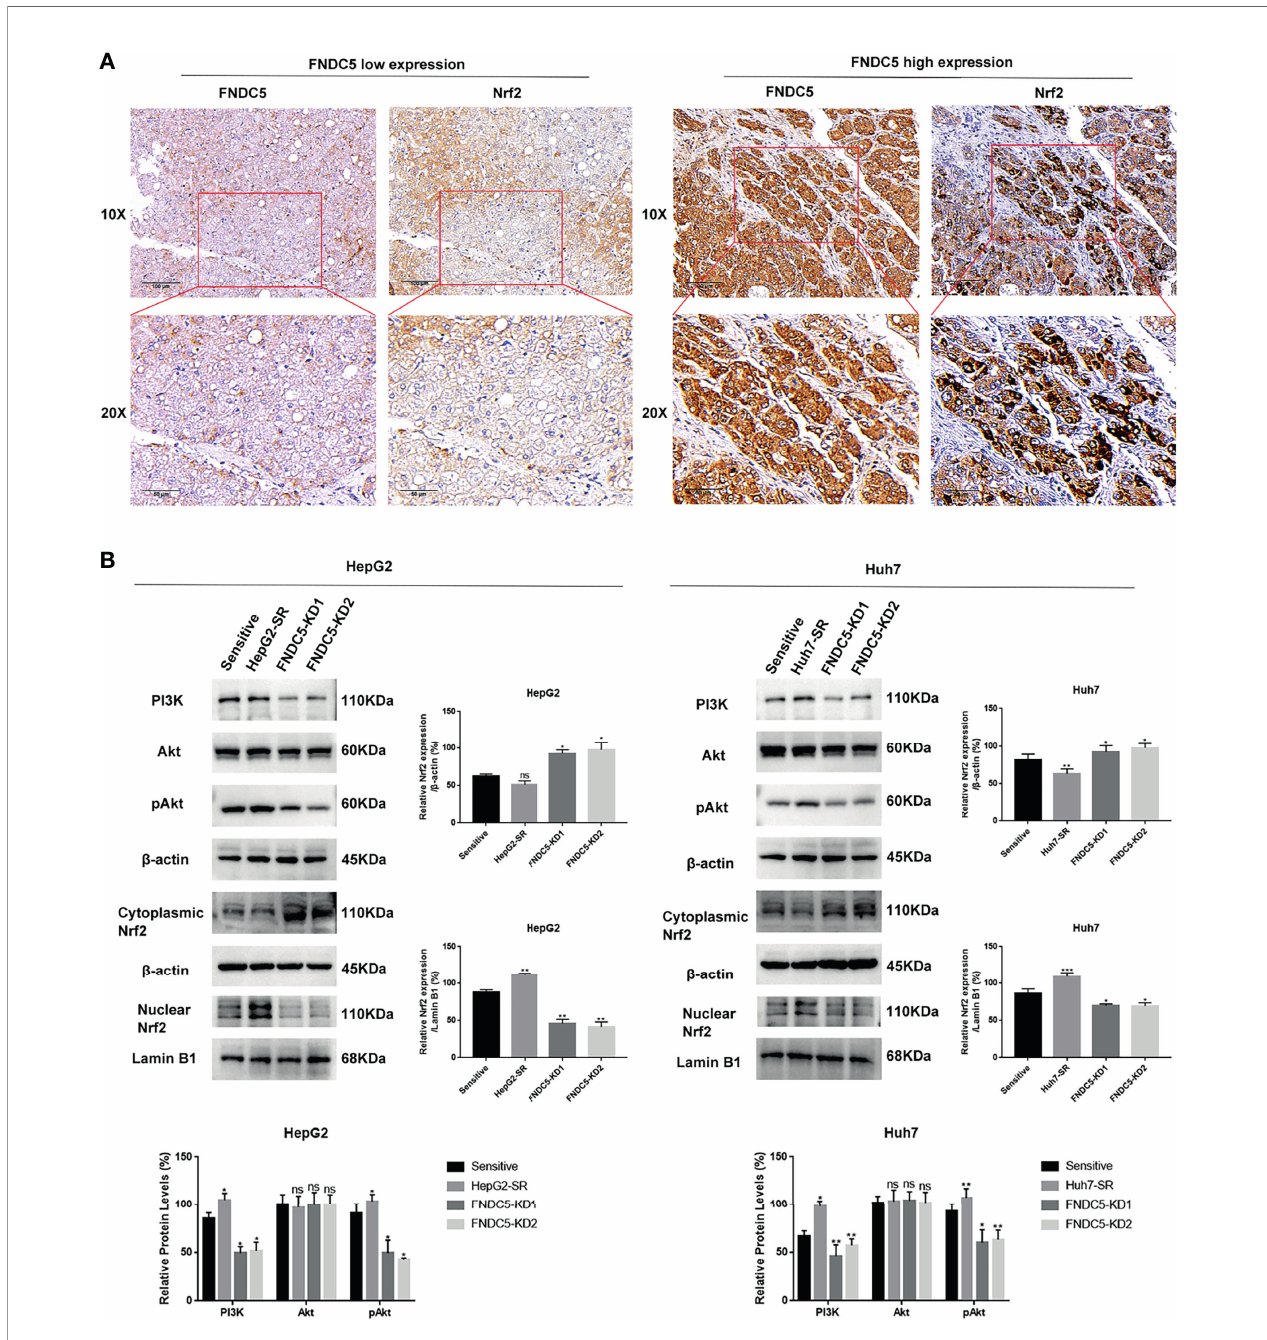
FIGURE 4 | Changes in the expression level of FNDC5 affect the expression level of Nrf2. (A) Nrf2 expression was elevated in hepatocellular carcinoma tissues with high FNDC5 expression. (B) sorafenib-sensitive HCC cells, drug-resistant, and FNDC5-knockdown resistant cells were treated with sorafenib (10 µM) for 24 h, and the levels of PI3K/Akt/Nrf2 pathway proteins were detected in each group of cells using western blotting. *Compared with the sorafenib-sensitive HCC cells, *p < 0.05, **p < 0.01, ***p < 0.001. ns, no signi fi cant